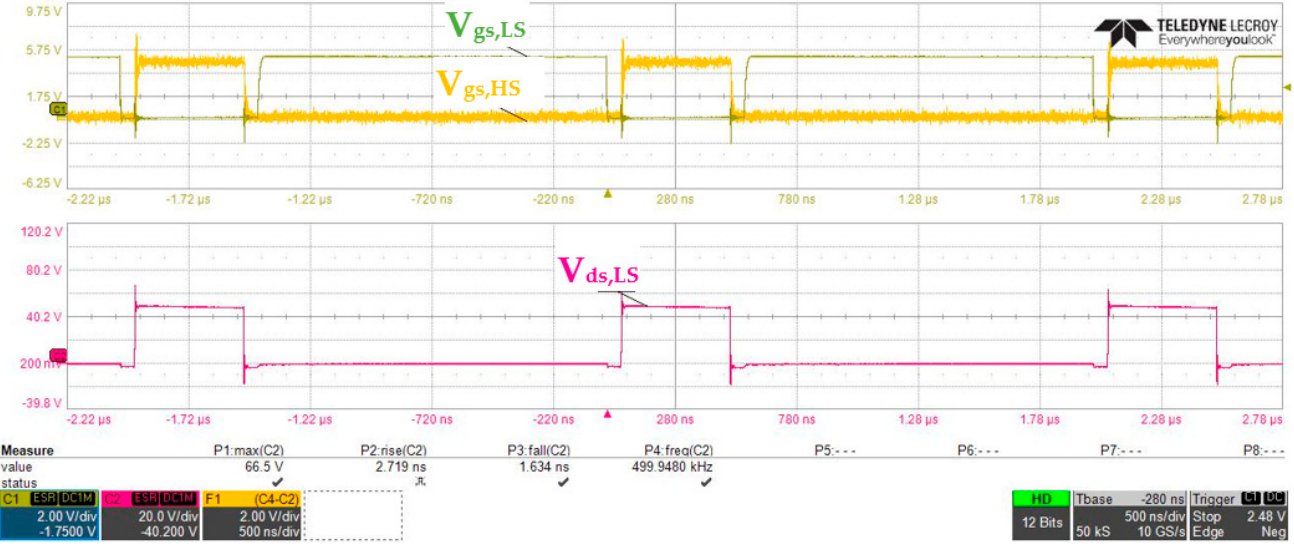
Figure 6. Main switching waveforms at 20 A load.